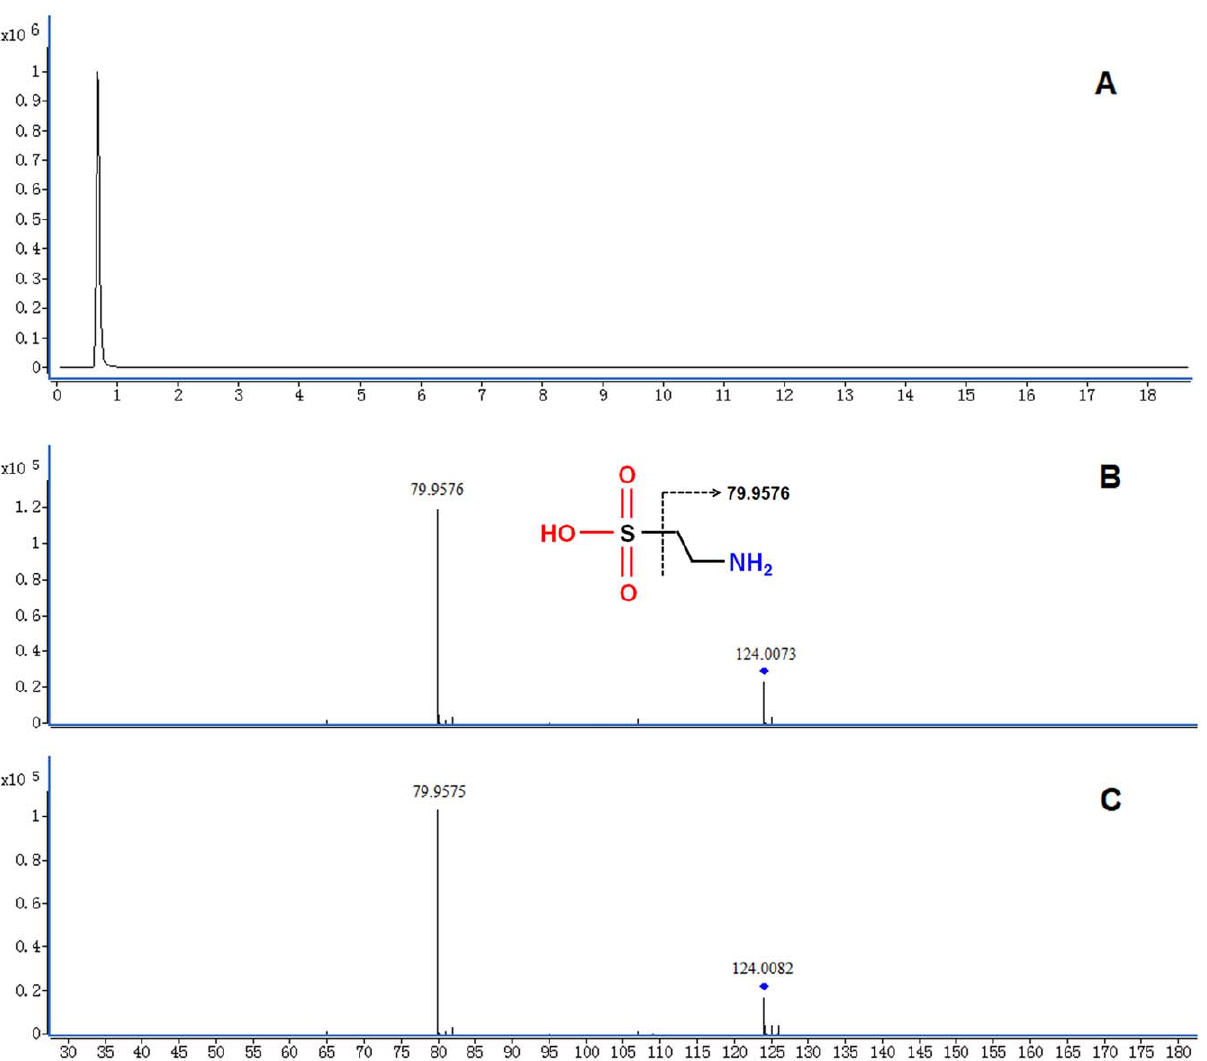
Figure 4. Identification of a selected marker ( m/z 124.0082). ( A ) Extracted ion chromatogram (EIC) of m/z 124.0082 (t R =0.69 min); ( B ) MS/MS spectrum of the ion in the urine; ( C ) MS/MS spectrum of a commercial standard. The collision energy was 18